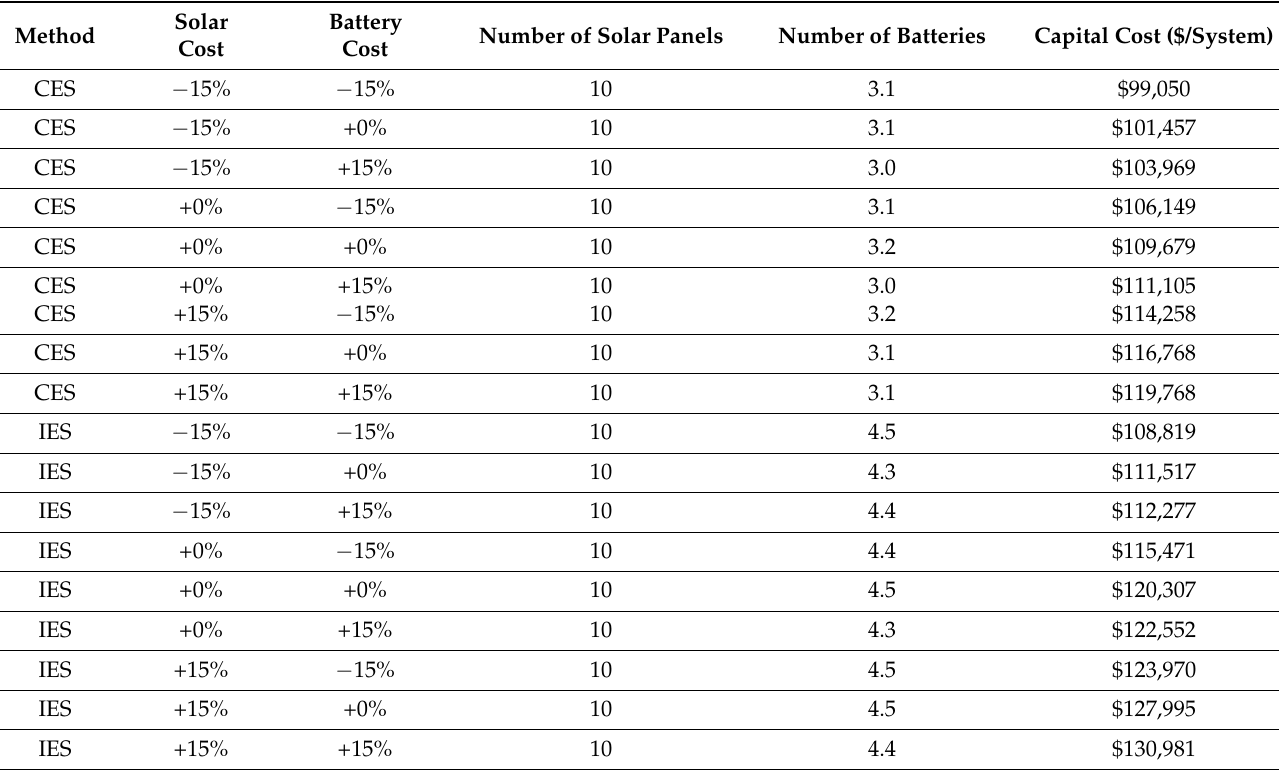
Table 5. Results of varying unit cost of energy storage and solar panels in Indianapolis given 5 systems, starting month of June, 0.1% LPSP required, 100 trials, and 10% initial battery